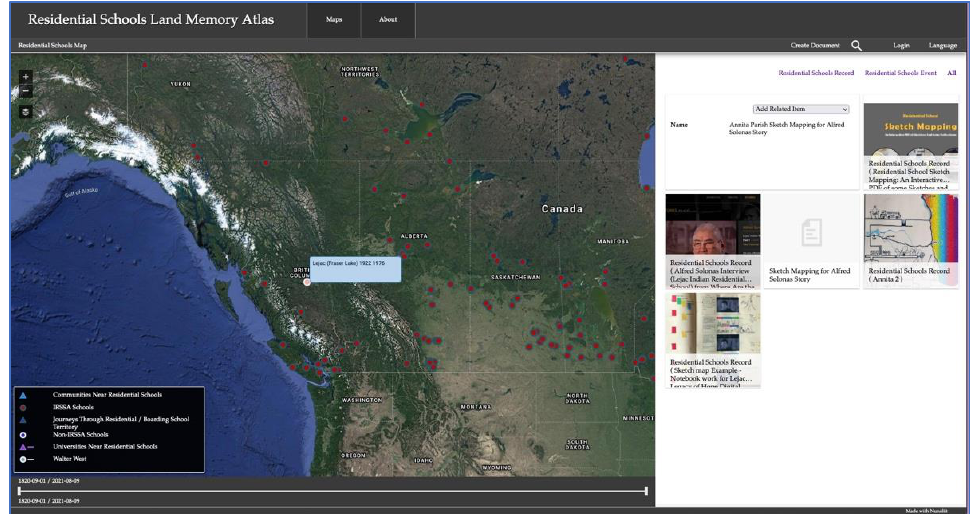
Figure 2. Screenshot of the Residential Schools Map of the Residential Schools Land Memory Atlas, showing thumbnail views of the sketch mapping by Annita Parish in relation to the story of Alfred Solonas in the side panel and the location for Lejac (Fraser Lake) Residential School in the center map panel (Available online: https://residentialschoolsatlas.org/index.html?module=module.resi- dential_schools#eyJ0IjoieCIsImkiOiJiMzBkMjVkMTg2MDdjM2ZmNWJmOTcwZTQzNDNjOD- BkNSIsInMiOjE2NDQ3Njc2NDYzOTZ9, (accessed on 1 April 2022)).